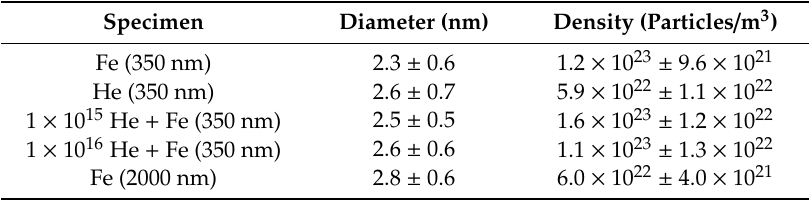
Figure 10. Dispersoid densities of Fe irradiated, He implanted and He + Fe irradiated samples as a function of depth. The He ion profiles and Fe damage curve are superimposed. The densities increased within the ion range for all cases, and the highest density was observed after the 1 × 10 15 He + Fe irradiation. Table 1. Summary of coherent oxide dispersoid size and density for each irradiation case. Table 2. Summary of coherent oxide dispersoid size and density for each irradiation